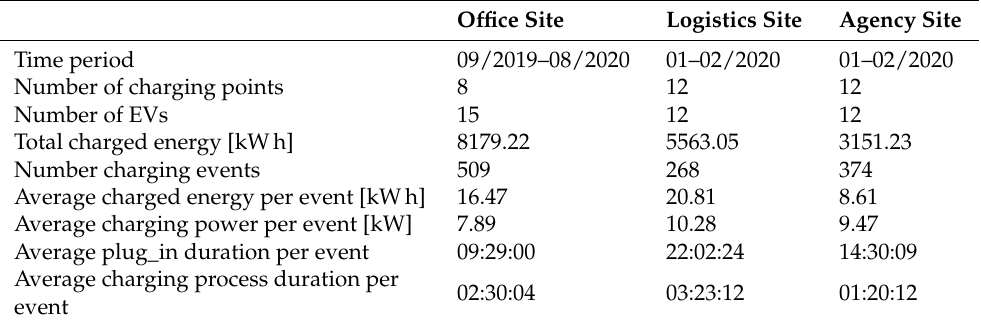
Table 2. Data basis of the